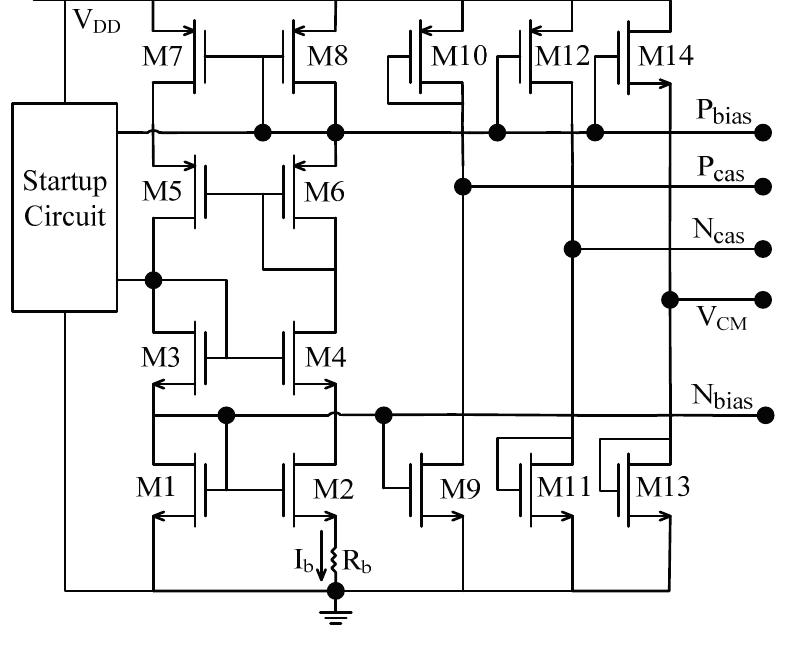
Figure 2. Schematic of the constant- g m biasing